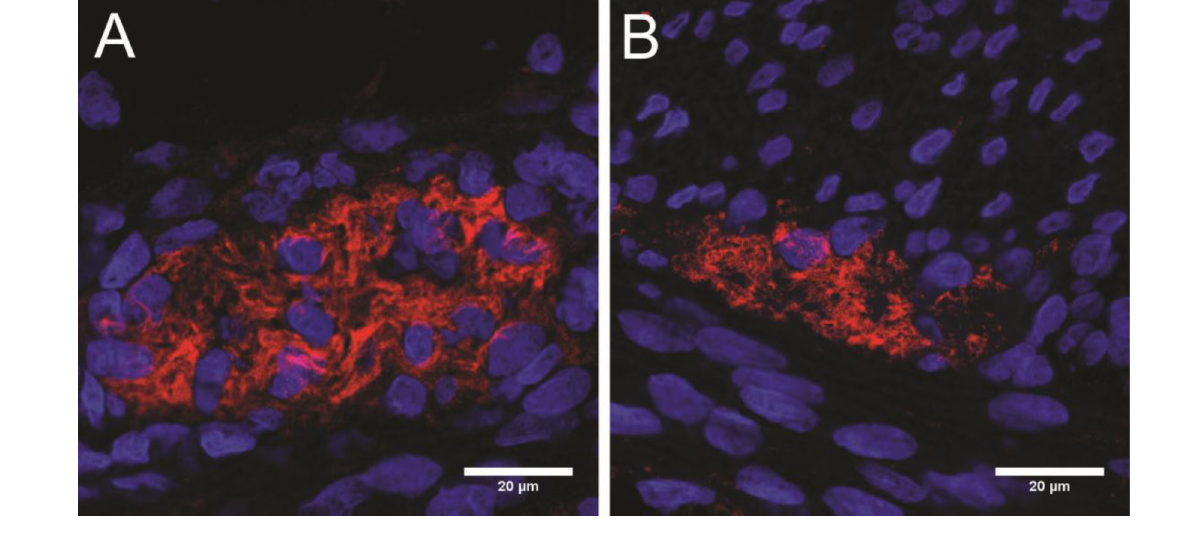
figure 8. Distortion of enteric glial cells in myenteric plexus 7 d after HI. Representative sections of fetal ileum stained by immunofluo- rescence for GFAP (red), a marker for enteric glial cells, and DAPI (blue), a marker for nuclei. Control animals appeared with normal perinuclear GFAP immunoreactivity and intact glial processes (A), whereas animals subjected to HI appeared with loss of GFAP immuno- reactivity around the nuclei and aggregates of GFAP without clear enteric glial processes (B).